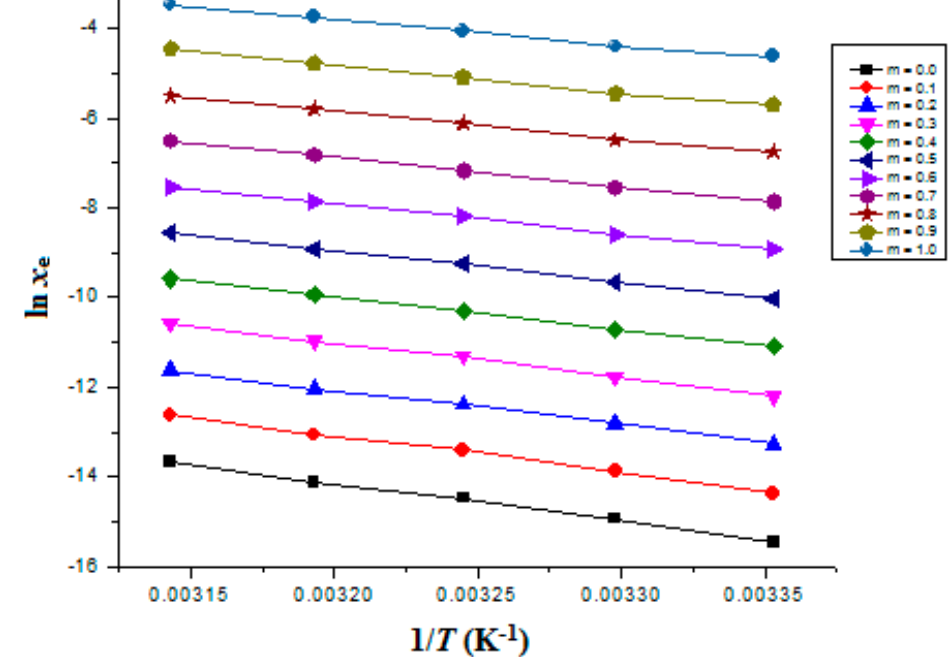
Figure 5. Correlation of experimental FXT (3) solubilities with the “Apelblat model” in various {PEG 400 (1) + H 2 O (2)} mixtures as a function of 1/ T ; symbols denote the experimental FXT solubility data, whereas solid lines denote the “Apelblat model” FXT solubility data . Table 6. Results for the Apelblat model for FXT (3) in several {PEG 400 (1) + H 2 O (2)} combinations.